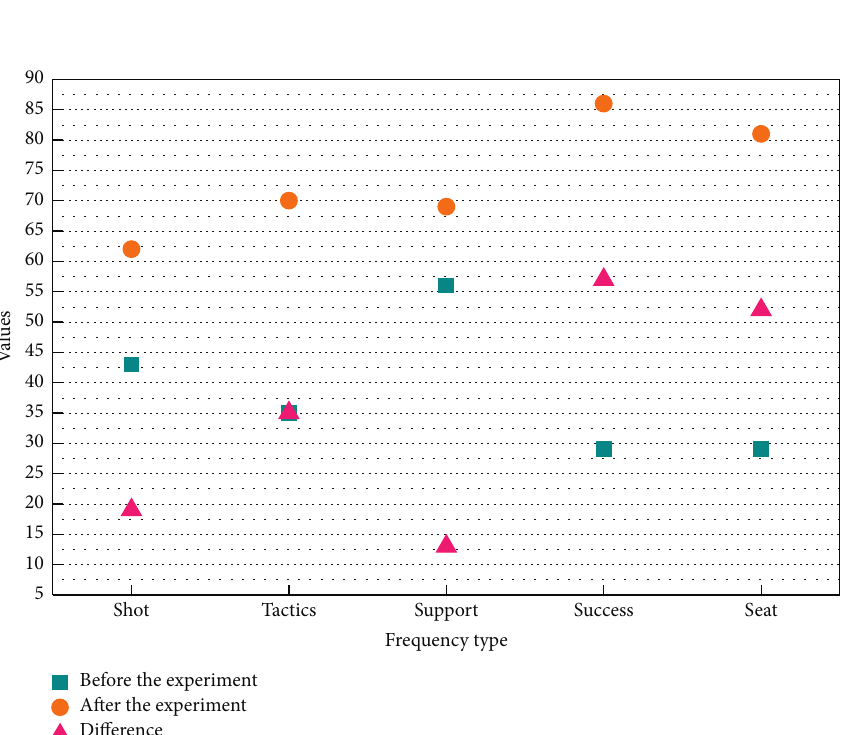
Figure 4: Statistical results of real-time analysis before and after the experiment.